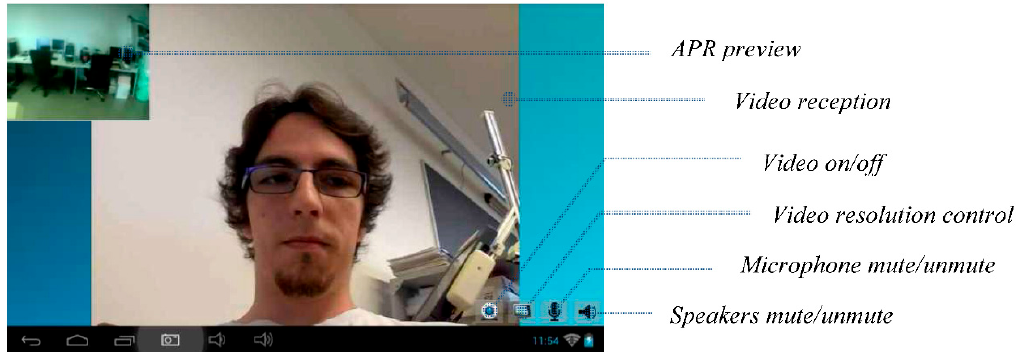
Figure 13. Screenshot of the Tablet of the APR showing the face of the person calling.